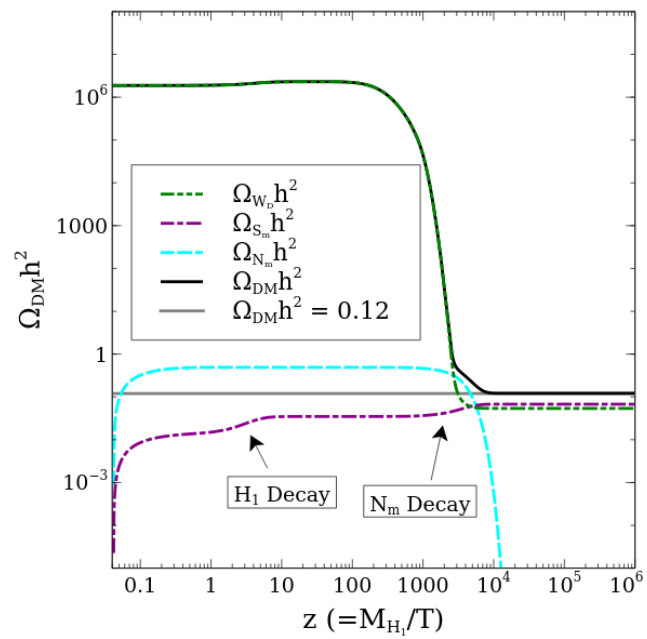
JHEP12(2022)165 Figure 8 . DM production by the freeze-out and freeze-in mechanisms and its evolution in terms of z ≡ M . The model parameters are chosen as M = 300 GeV, M = 20 GeV, M = H 1 /T N m S m W D 1 . 04628 GeV, Λ = 5 . 5 × 10 14 GeV, κ = κ 0 = ξ = ξ 0 = α = α 0 = 1 , M = 2 . 212 GeV, g = 3 . 1 × 10 − 4 , H 2 D δ = 10 − 2 , and sin α = 8 . 17 × 10 − 2 . For the reheating temperature, we have used T R = 3 TeV. The green double-dot-dashed (purple dot-dashed) line corresponds to the WIMP (FIMP) DM relic density. The cyan dashed line represents the NLSP relic density. The sum of the WIMP and FIMP DM relic densities is depicted by the black solid line, while the grey solid line shows the present DM relic density measured by the Planck, Ω 2 = Ω 2 = 0 . 12 DM h Tot h